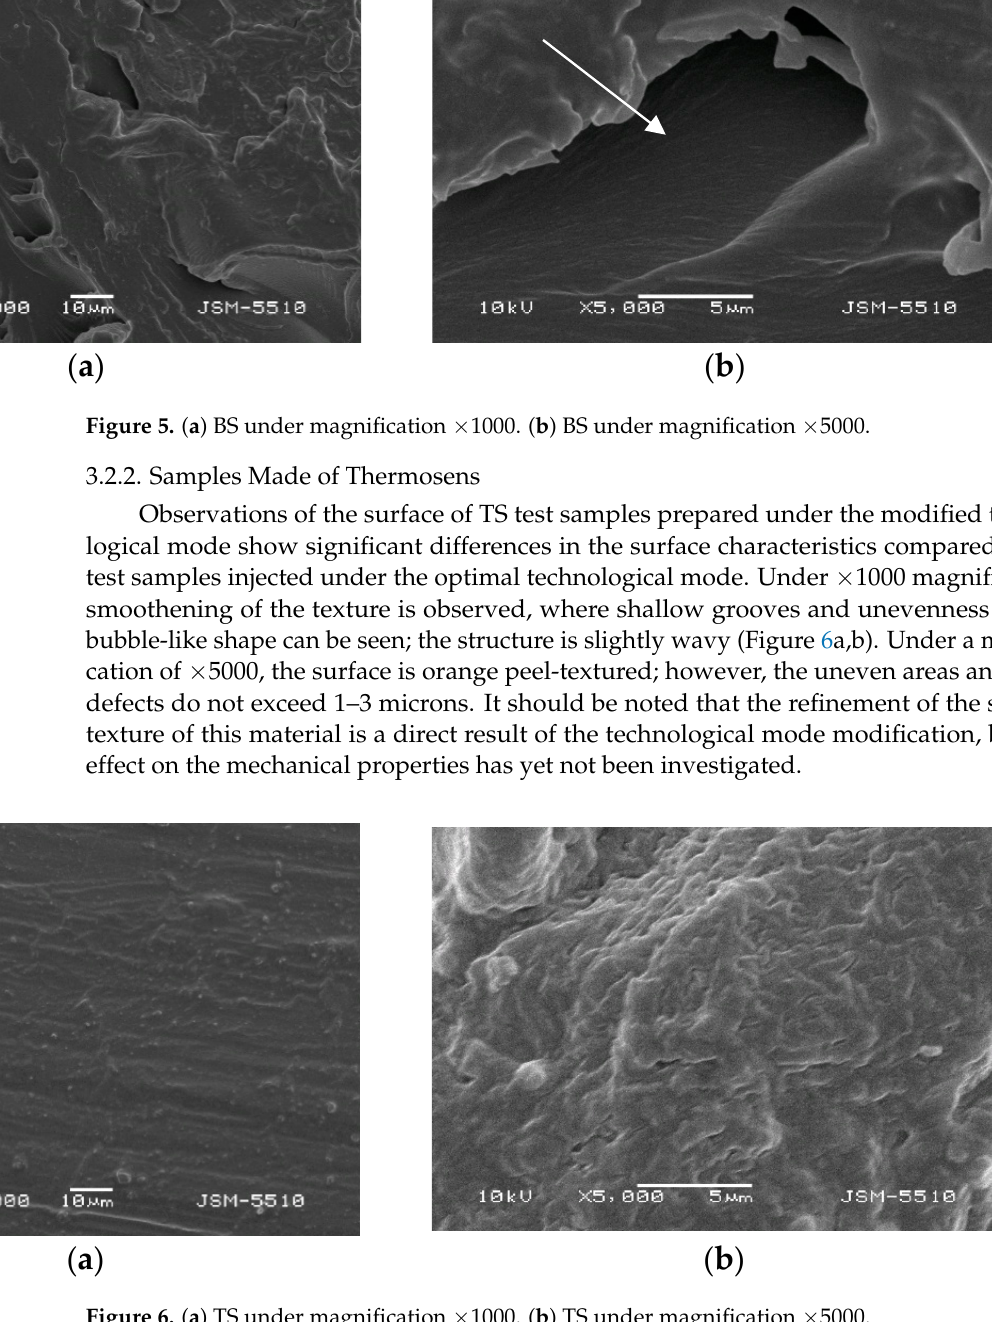
Figure 6. ( a ) TS under magnification ×1000. ( b ) TS under magnification ×5000.